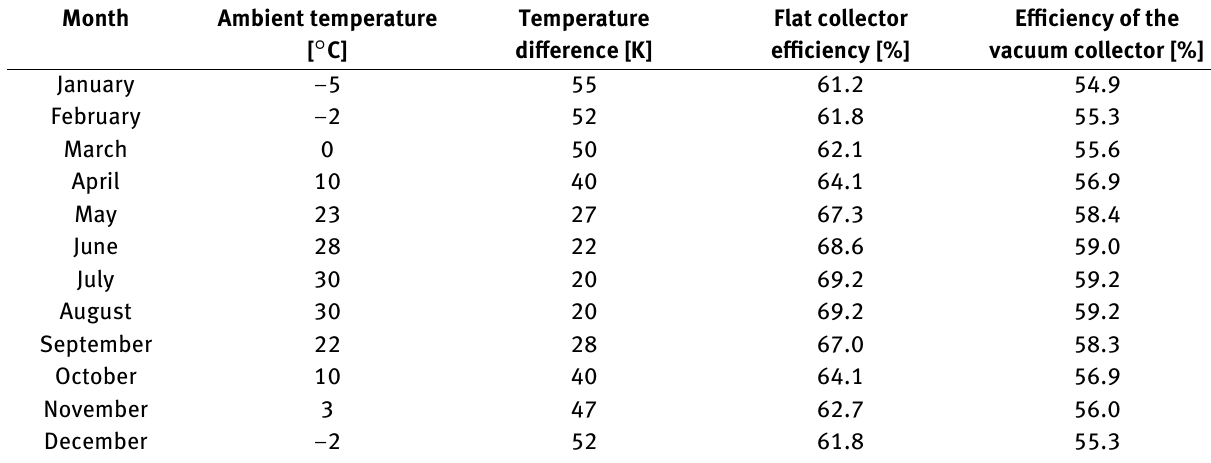
Table 1: Final results of collector